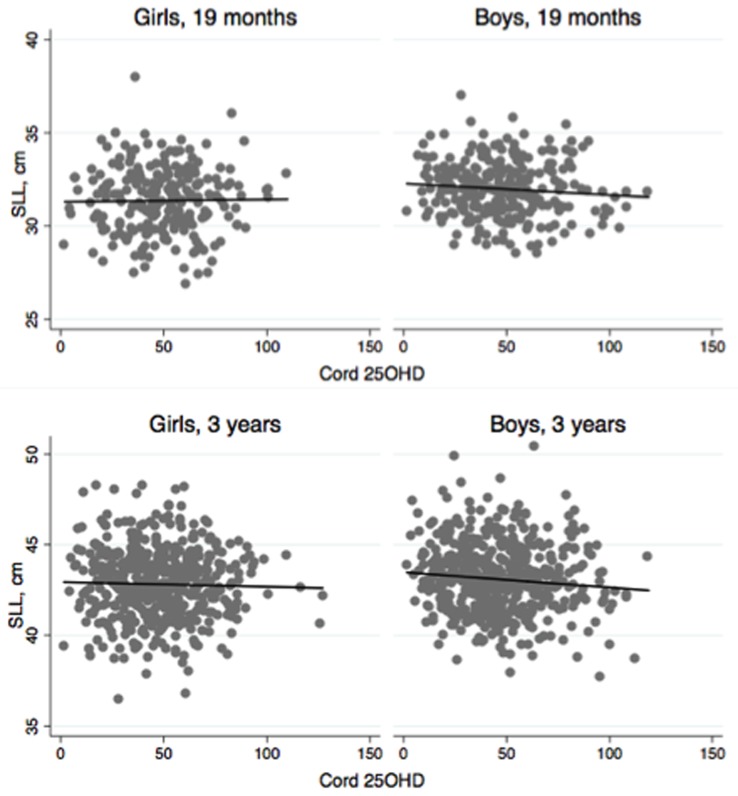
Scatterplot of the crude association between cord 25OHD and SLL at 19 months and three years by child sex.Sub-ischial leg lengths (SLL) in cm for cord 25-hydroxyvitamin D (25OHD) in nmol/L fitted with a linear model. No significant, crude associations were observed between cord 25OHD and SLL in either sex. Abbreviations: SLL: sub-ischial leg length. 25OHD: 25-hydroxyvitamin D.